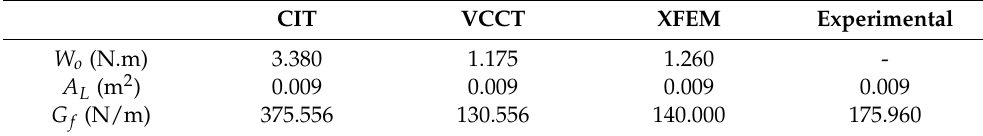
Table 3. Fracture energy